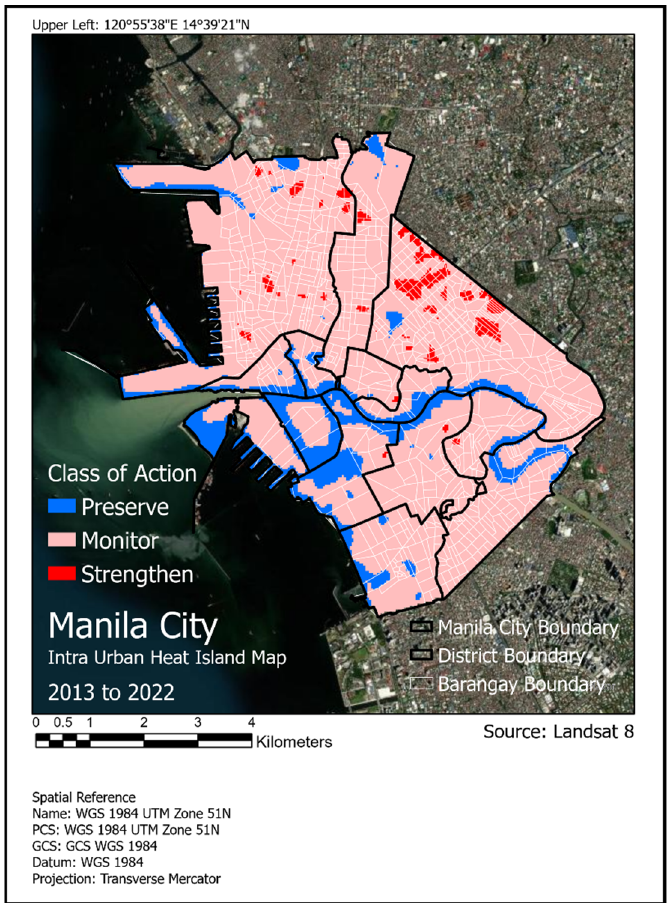
Figure 13. Intra-Urban Heat Island Map of Manila City